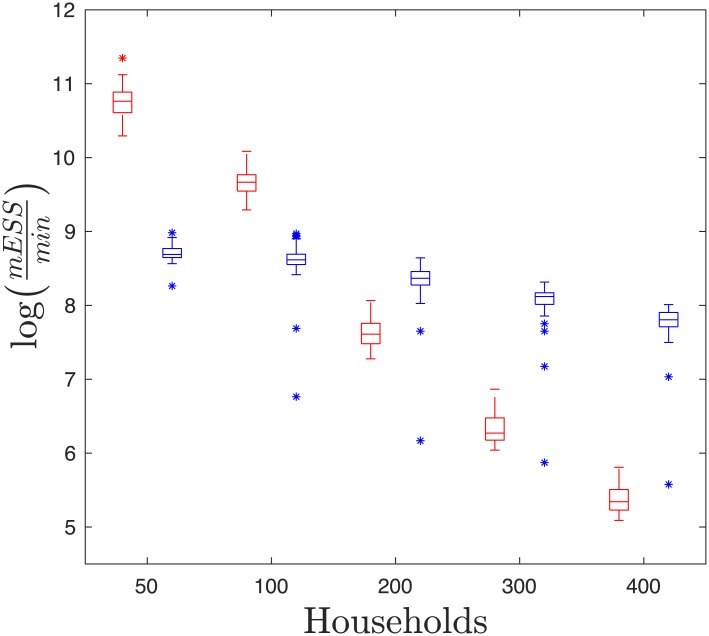
Boxplots of the efficiency of each method against the number of infected households.Here efficiency is presented in terms of log multivariate effective sample size per hour. These estimates are based upon running each algorithm for a 50 simulations with 50, 100, 200, 300 and 400 infected households.